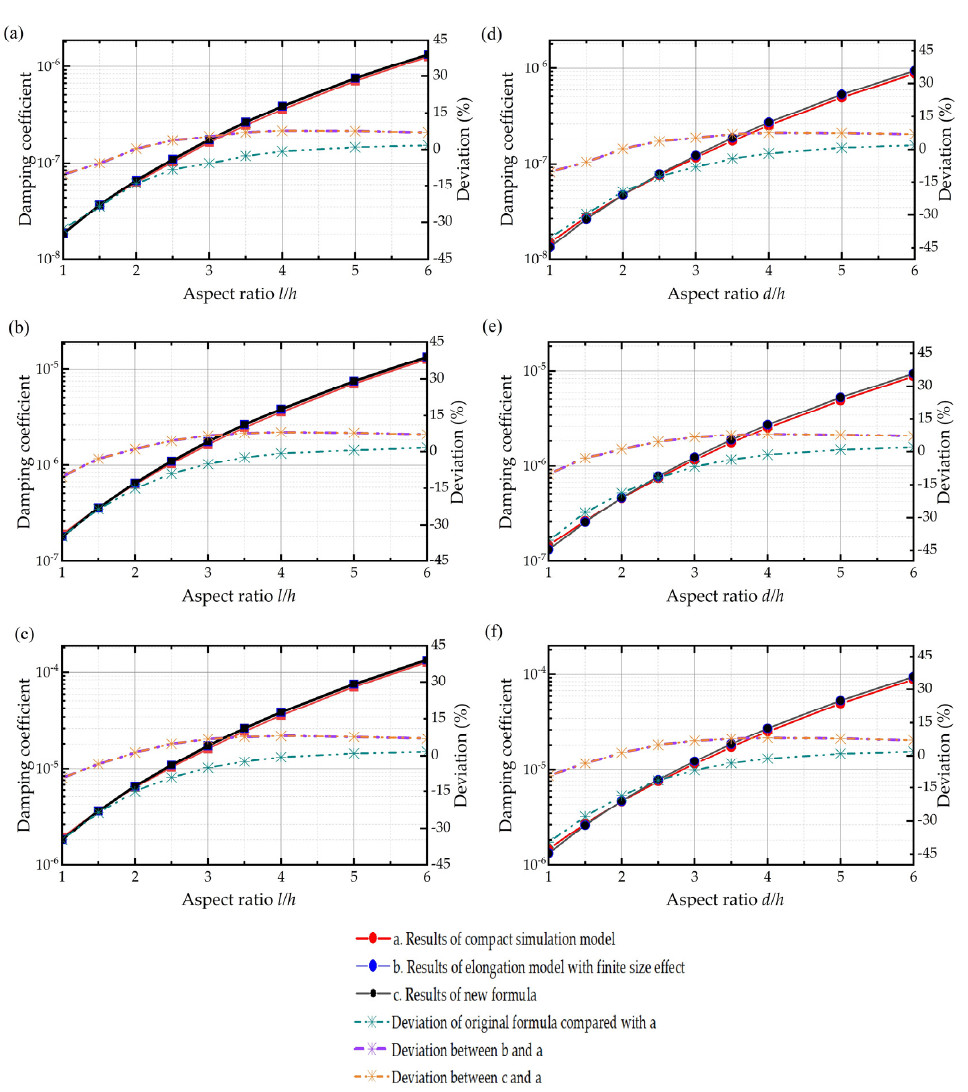
Figure 9. Damping coefficients of simulation results with the compact model and elongation model with the finite size effect and theoretical results of the compact modified calculating formula along with the deviations between them. ( a – c ) Rectangular plate when the air film thickness is 0.06 mm, 0.6 mm, and 6 mm from top to the bottom. ( d – f ) Circular plate when the air film thickness is 0.06 mm, 0.6 mm, and 6 mm from top to the bottom.